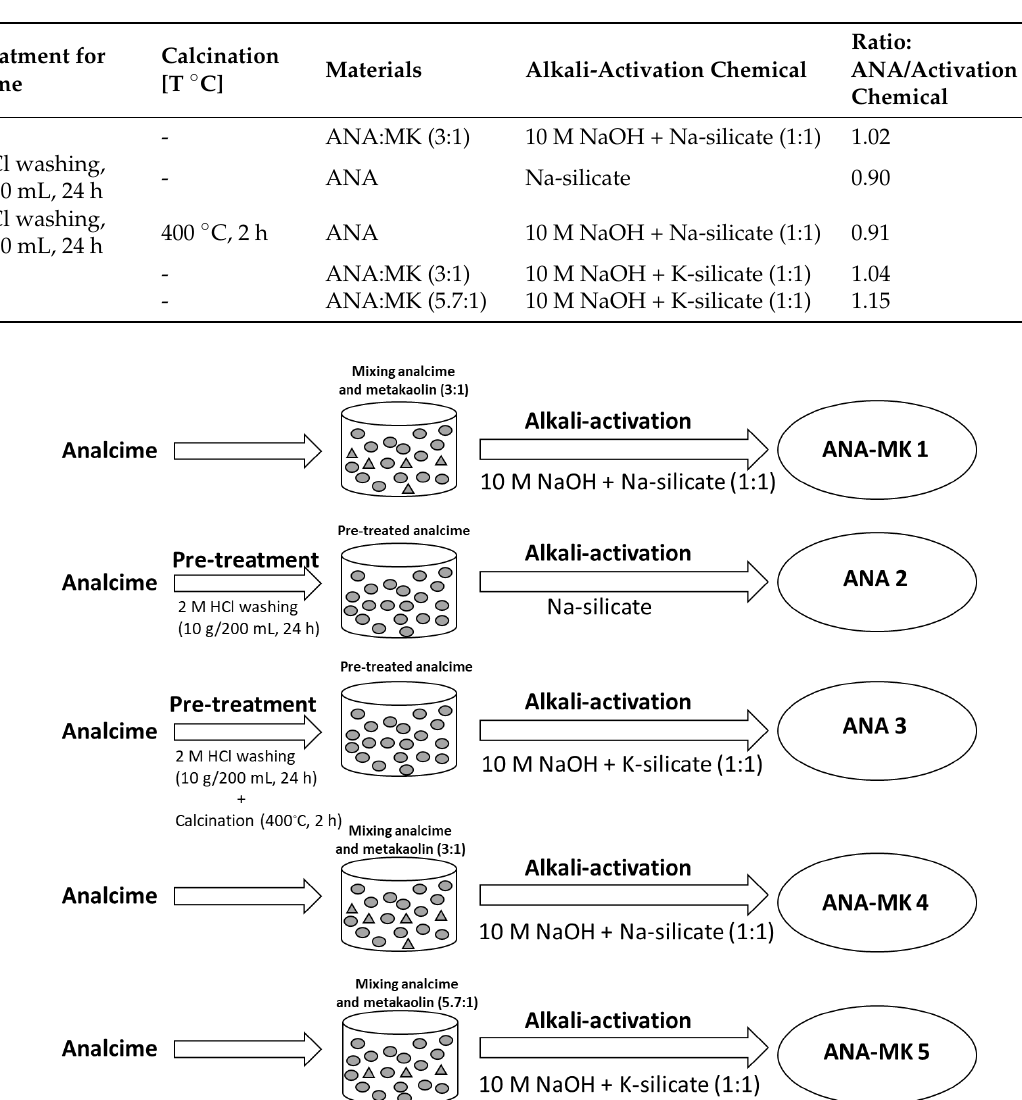
Table 2. Production conditions for the alkali-activated analcime sorbents.